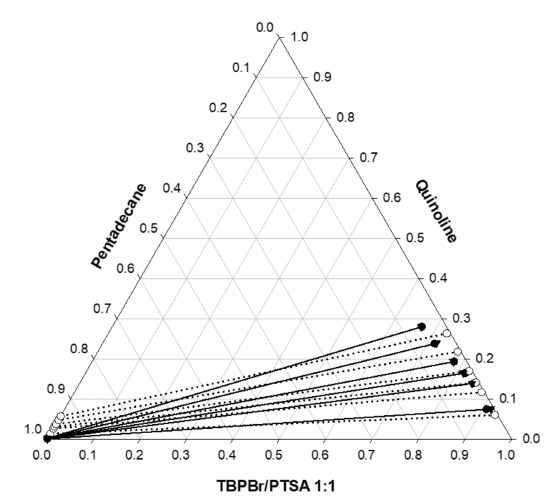
Figure 9. Ternary phase diagram for TBPBr / PTSA + quinoline + pentadecane at 25 ◦ C. The solid line represents experimental data, dotted line represents COSMO-RS prediction, and the dashed line represents NRTL LLE